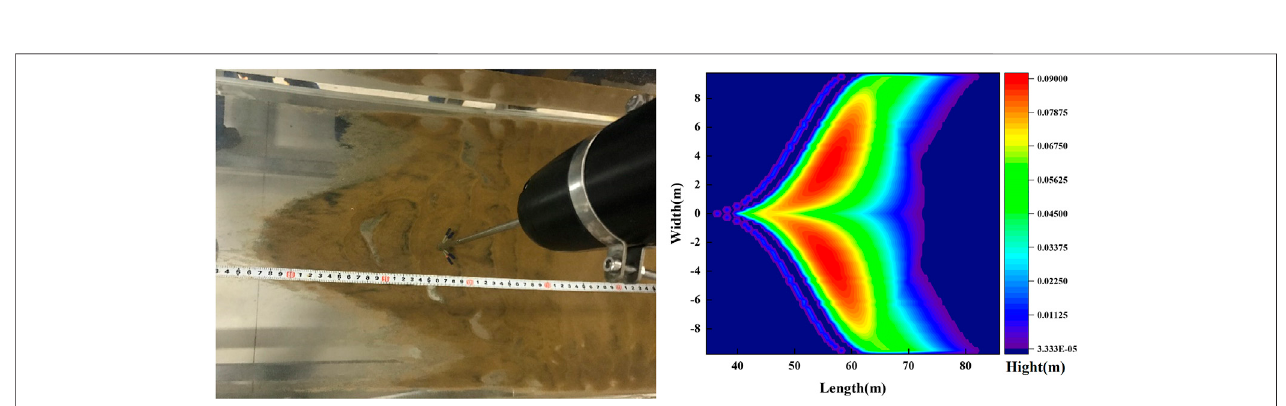
FIGURE 9 | Comparison of experimental and model calculation results of sedimentary bed morphology distribution.